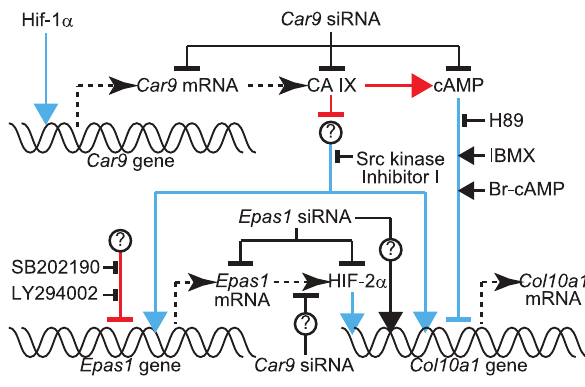
Figure 9. Schematic representation of possible roles of CA IX in regulation of Col10a1 expression in chondrocytes. Blue and red lines represent pathways already known and those indicated in this study, respectively. Arrows with equilateral-triangular heads and T- shaped bars show facilitation and suppression of the pathways, respectively. HIF-1 a induces the expression of Car9 mRNA and hence that of CA IX protein [8]. It is known that cAMP-dependent pathways inhibit hypertrophic differentiation of chondrocytes including the expression of Col10a1 [26-29]. On the other hand, it is reported that HIF-2 a , encoded by Epas1 gene, transactivates the Col10a1 gene